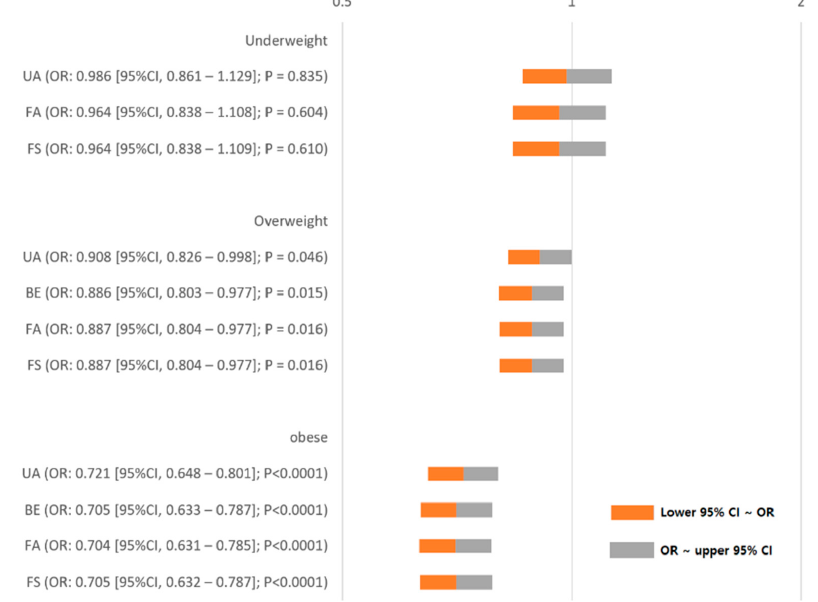
interval; OR, odds ratio. Covariates for overweight BE: age, female, operation duration, American Society of Anesthesiologists physical status, use of N 2 O, patient-controlled analgesia, smoking, use of